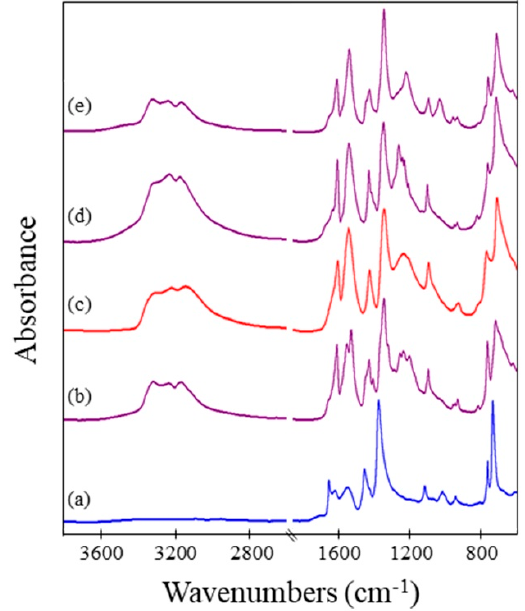
Figure 6. IR spectra of HKUST-1 powder (obtained commercially as Basolite ® C 300) ( a ) before gas exposure; ( b ) after NH 3 exposure without activation; ( c ) after NH 3 exposure with prior activation; ( d ) after H 2 O vapor and subsequent NH 3 exposure without activation; ( e ) after DMSO and subsequent NH 3 exposure without activation.